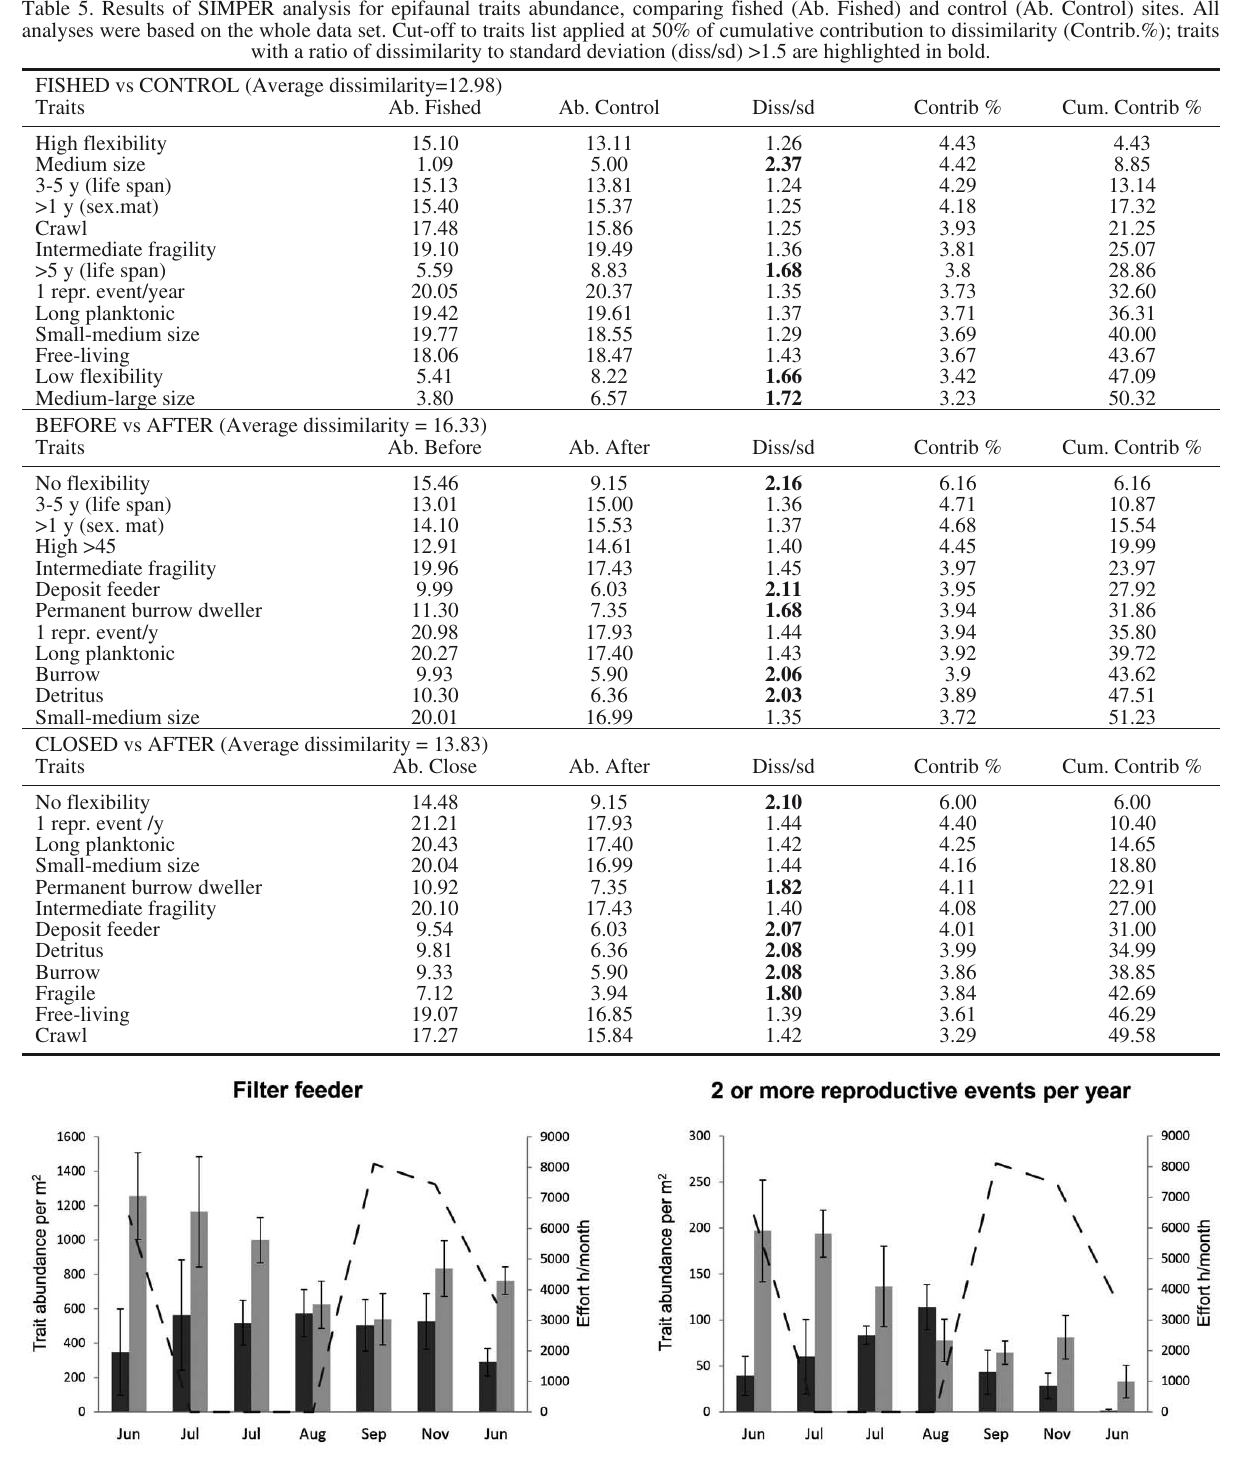
Fig. 5. – Mean (±se) trait abundance of infauna at fished (black bars) and control sites (grey bars). Dashed line shows fishing effort. June corresponds to before closure period, July and August to closed season and September and November to after closure